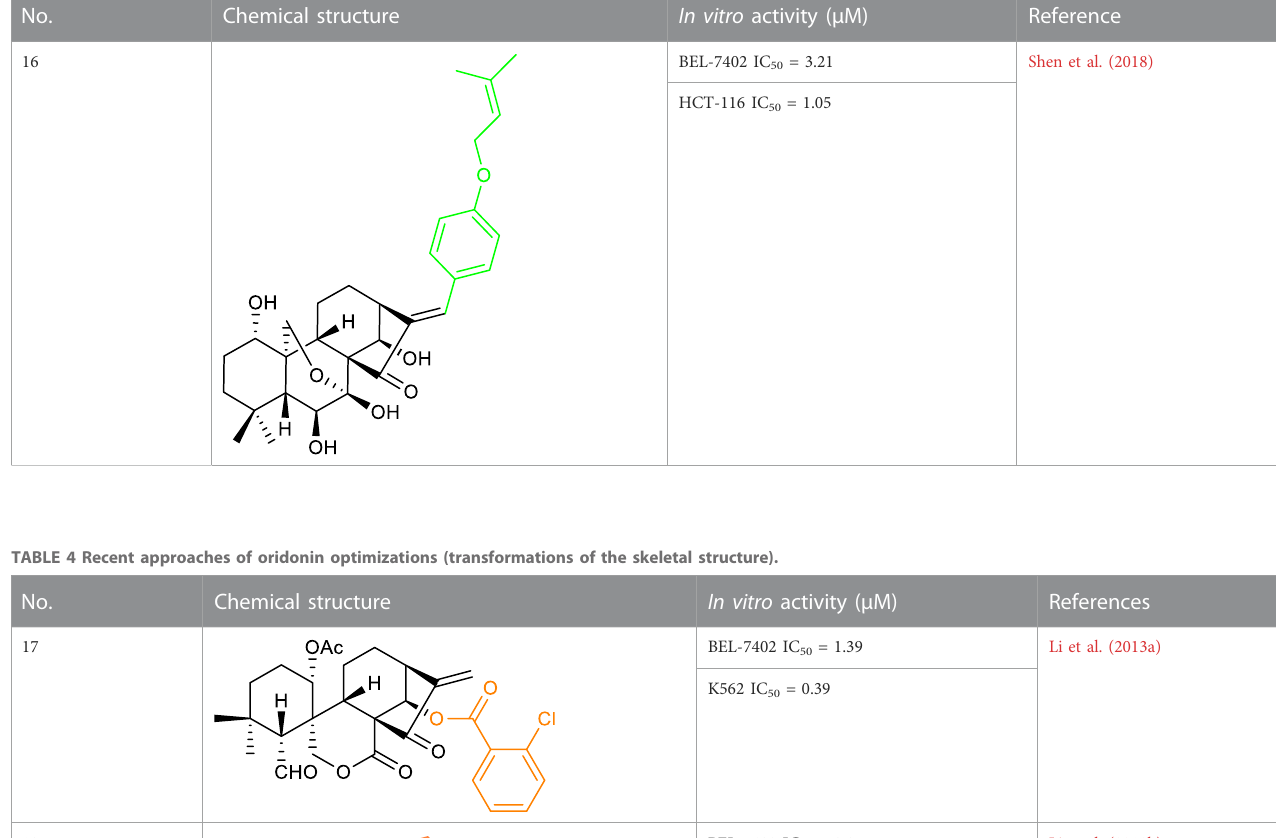
TABLE 3 Recent approaches of oridonin optimizations (modi fi cations of D-ring - α , β -unsaturated ketone). No.